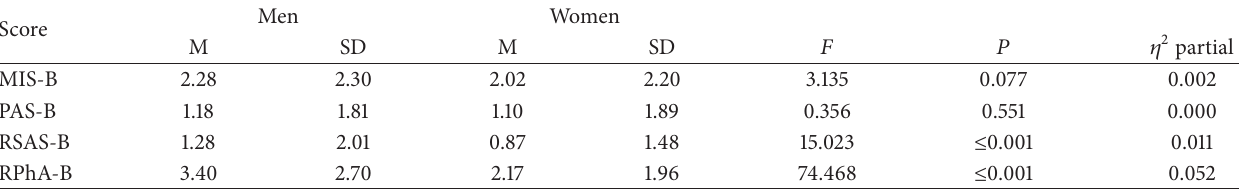
Table 4: Mean scores comparisons in the Wisconsin Schizotypy Scales-Brief by